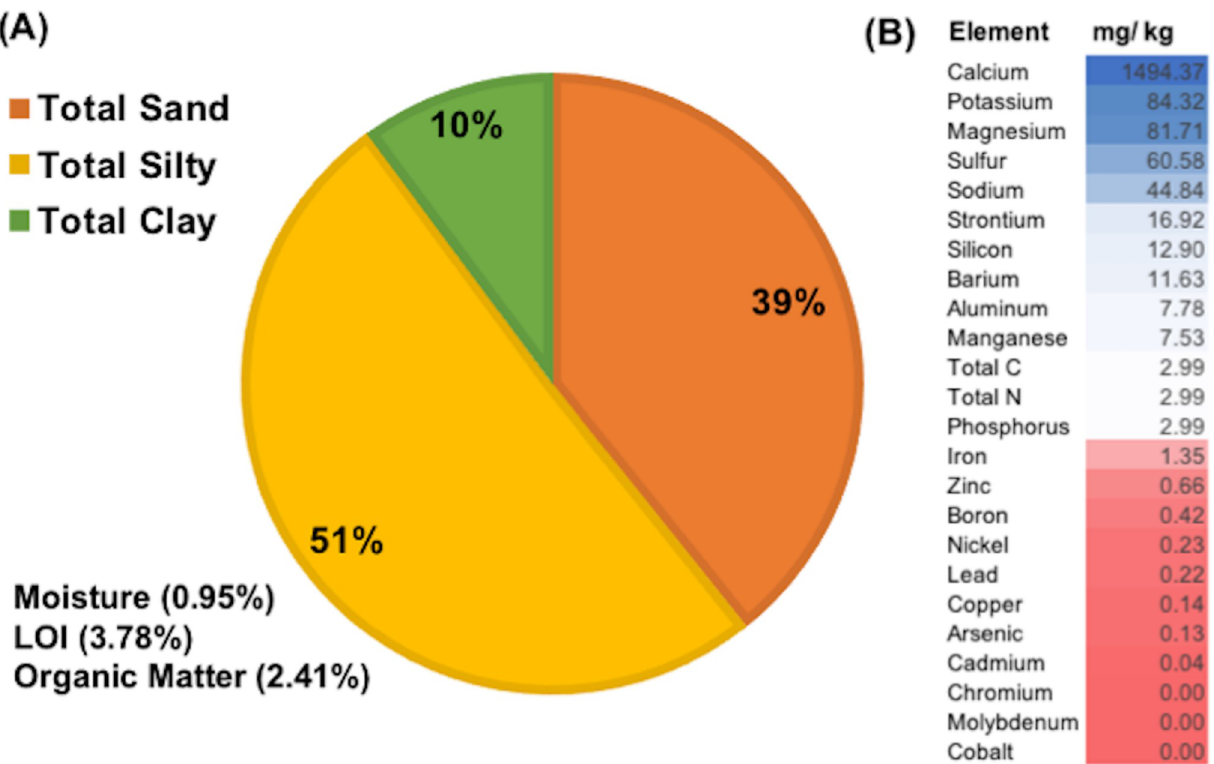
Fig 2. Composition of the bulk soil collected across the experimental apple orchard in a ‘HoneyCrisp’ block with rapid apple decline. (A) Physical properties and (B) Chemical composition of soil samples ranging from the highest (blue) to the lowest (red) order.